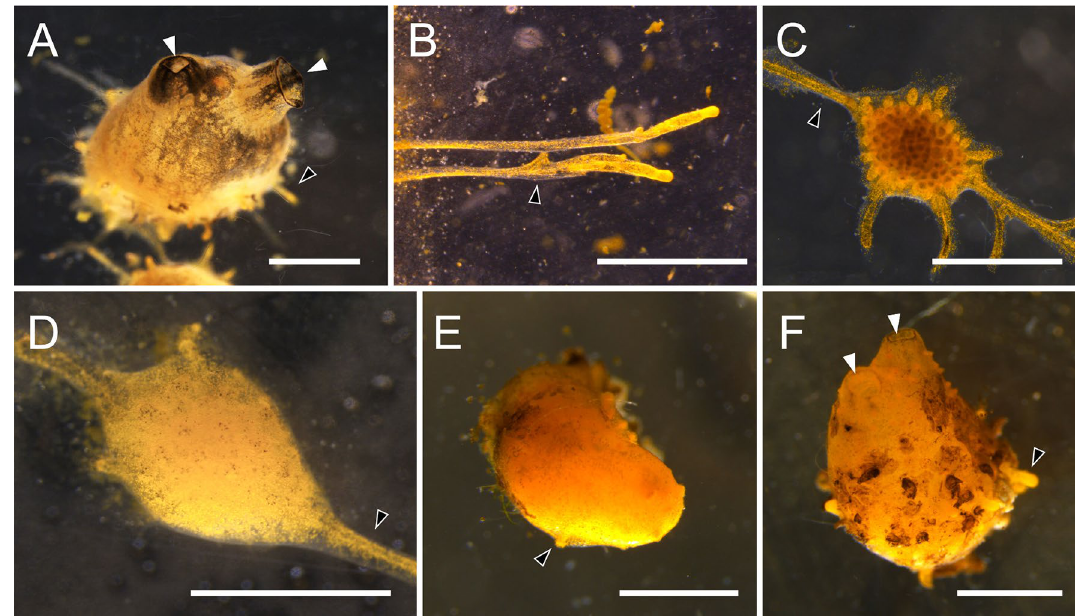
Figure 3. Photomicrographs of Polyandrocarpa zorritensis asexual stages . ( A ) Zooid. Siphons (white arrowheads) open for feeding. Stolons (black arrowhead marks one as an example) help attach the zooid to the substrate, and have begun to grow laterally. ( B ) Stolons attached firmly on a glass slide. Lower stolon starting to ramify (black arrowhead) where new pre-bud will likely develop. ( C ) Pre-bud still attached to “parental” zooid by stolon (black arrowhead), thus no bud tissues have begun to develop. Ramifications of vasculature seen within the structure through the tunic. ( D ) Early spherule, as indicated by thickened tunic, which obscures